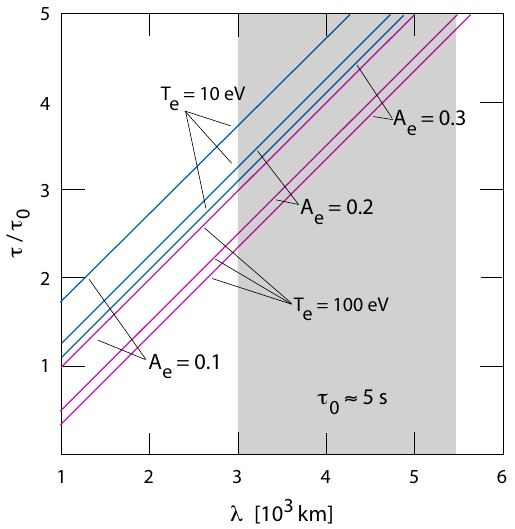
Fig. 5. The Weibel mode at long wavelengths: Growth time depen- dence on wavelength in the long wavelength range. The normalisa- tion τ 0 ≈ 5s is obtained for T e = 100eV, N e = 1cm − 3 , and A = 0 . 1. Growth times are shown for two different temperatures T e = 10eV and T e = 100eV and three values of the anisotropy A = 0 . 1 , 0 . 2 , 0 . 3. The shaded area is the acceptable wavelength domain for the geo- magnetic